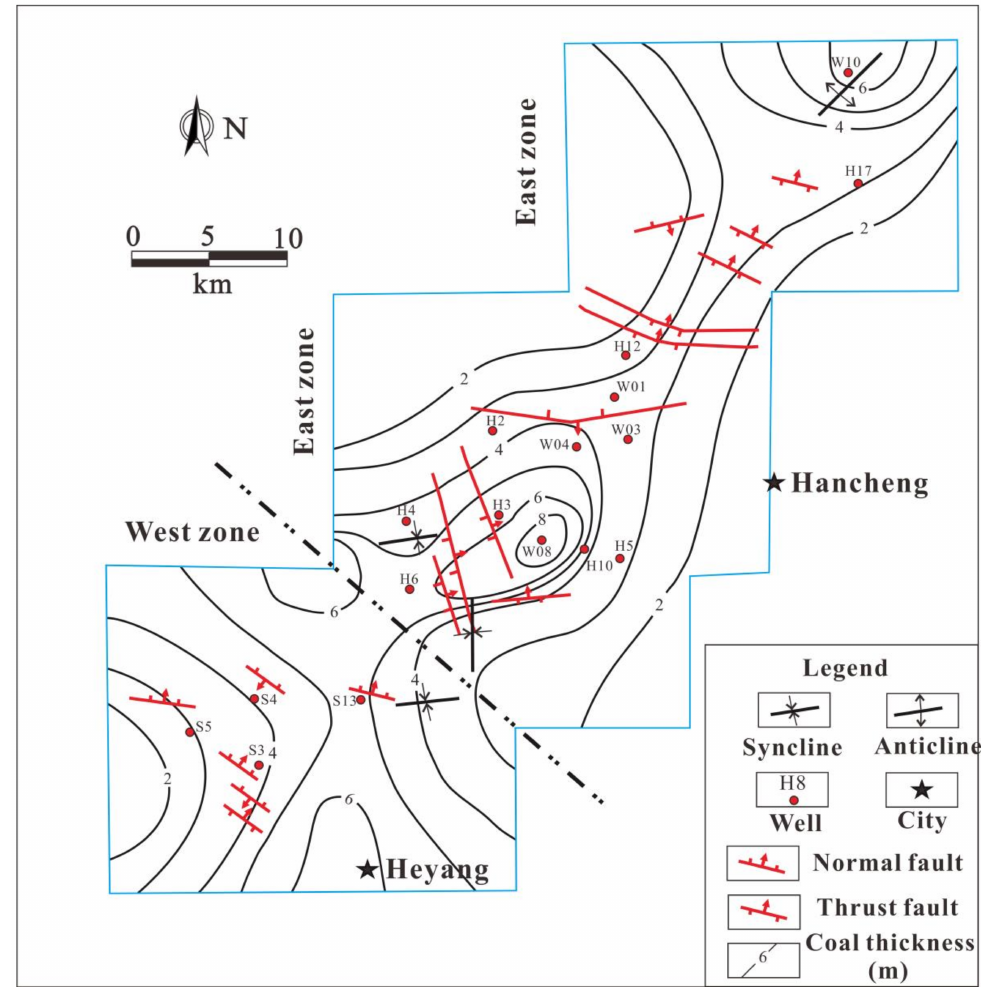
Figure 7. Thickness distribution of the No.5 coal seam in the Weibei